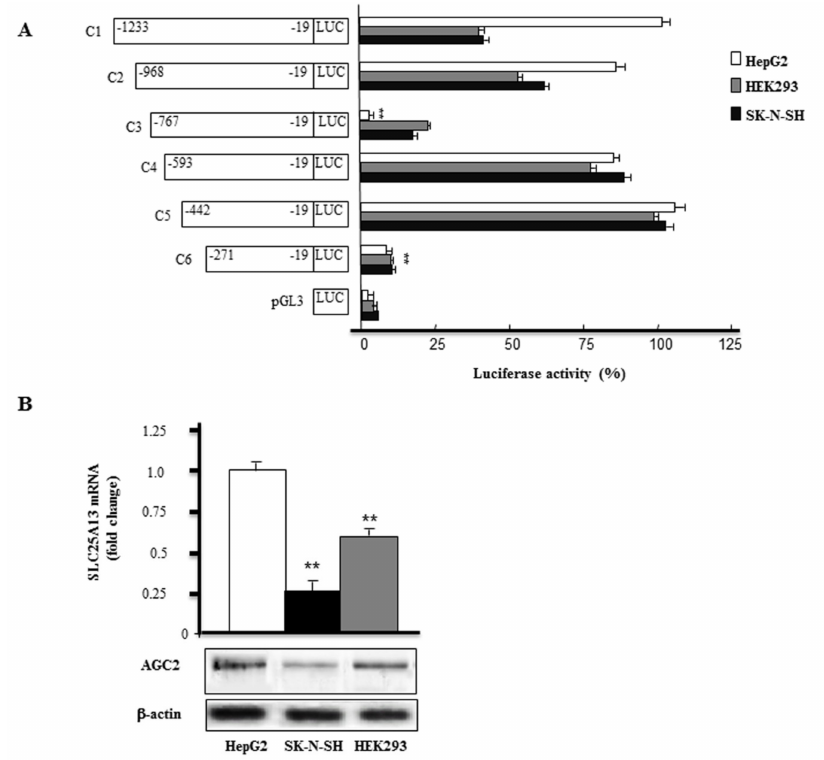
Figure 1. ( A ) Deletion analysis of the 5 (cid:48) -flanking region of the human SLC25A13 gene. The deletion mutants named C1-C6 were cloned into the pGL3 basic-LUC vector and tested for LUC activity in transfected HepG2, HEK293 and SK-N-SH cells. pGL3 indicates the pGL3 basic-LUC vector alone. Numbering indicates the extent of fragments, while bars indicate LUC activity. The values of construct C1 transfected in HepG2 cells were set to 100%. Means ± SD of three duplicate independent experiments are shown. ( B ) Total RNAs extracted from HepG2, HEK293 and SK-N-SH cells were used to quantify SLC25A13 mRNA by real-time polymerase chain reaction (PCR). Means ± S.D. of four replicate independent real-time PCR experiments are shown. Where indicated, di ff erences between samples and control were significant (** p < 0.01). AGC2 and β -actin proteins of HepG2, HEK293 and SK-N-SH cells were immunodecorated with specific antibodies. The Western blot analysis is representative of three independent experiments with similar